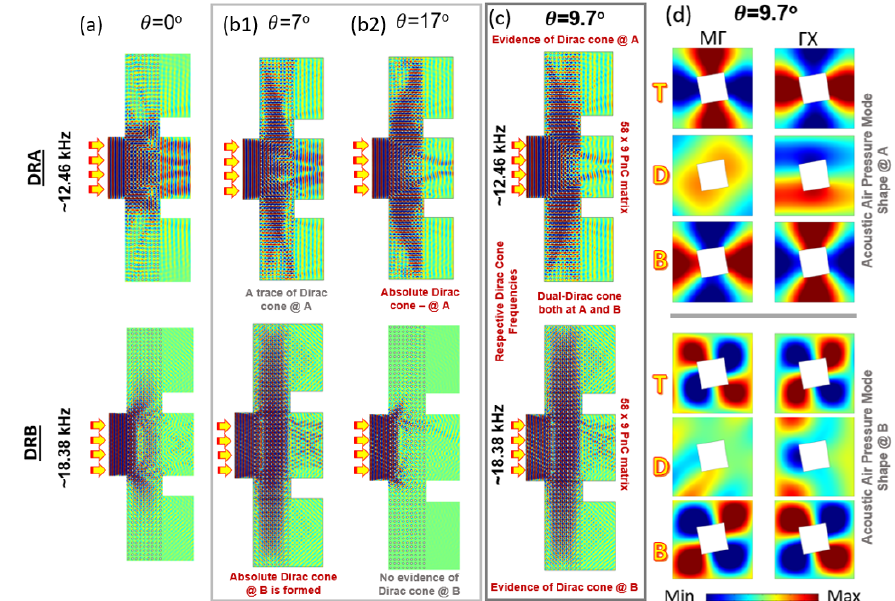
Figure 5. ( a ) Wave propagation and acoustic pressure distribution in a PnC guide with a 58 × 9 matrix